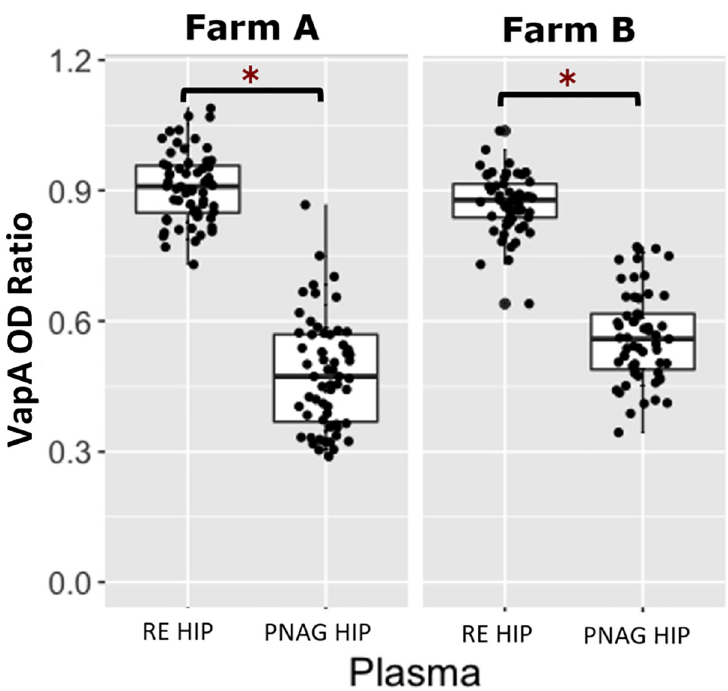
Fig 1. Comparison of VapA optical density ratios between R . equi hyperimmune plasma and PNAG hyperimmune plasma. Boxplots of optical density (OD) ratios from ELISAs measuring deposition onto purified VapA protein by serum antibodies in 119 foals from Farm A and 114 foals from Farm B stratified by plasma type, faceted by farm. Foals transfused with R . equi hyperimmune plasma (RE HIP) at both farms had significantly higher (asterisks represent P < 0.05) VapA OD ratios than foals that were transfused with PNAG hyperimmune plasma (PNAG HIP). The mean (95% CI) OD ratio of anti-VapA antibodies among foals at Farm A and B were 0.91 (0.89 to 0.93) and 0.87 (0.85 to 0.89), respectively among foals transfused with RE HIP and were 0.48 (0.45 to 0.52) and 0.56 (0.54 to 0.59), respectively, among foals transfused with PNAG HIP. activity, accounting for effects of farm (Fig 4, Table 1). Using multivariable logistic regression, the odds of pneumonia among foals transfused with RE HIP were approximately 7-fold higher